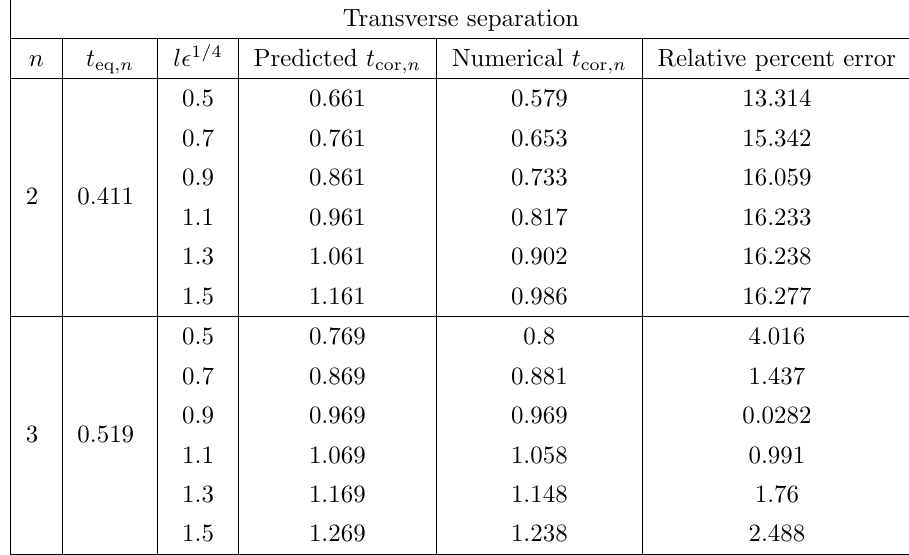
Table 3 . Example equilibrium times of the 1-point functions, t eq ;n , and 2-point functions, t cor ;n , in a thermalizing (cid:13)uid (dual to the evolution towards a Schwarzschild black brane geometry).